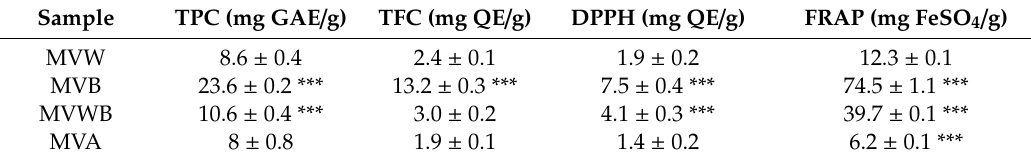
Table 2. Total phenolic content (TPC), total flavonoid content (TFC), and antioxidant activities of the aqueous extract (MVW), the aqueous extract of fermented leaves by B. subtilis MV1 (MVB), the fermented MVW by B. subtilis MV1 (MVWB), and aqueous extract of fermented leaves by A. oryzae (MVA).